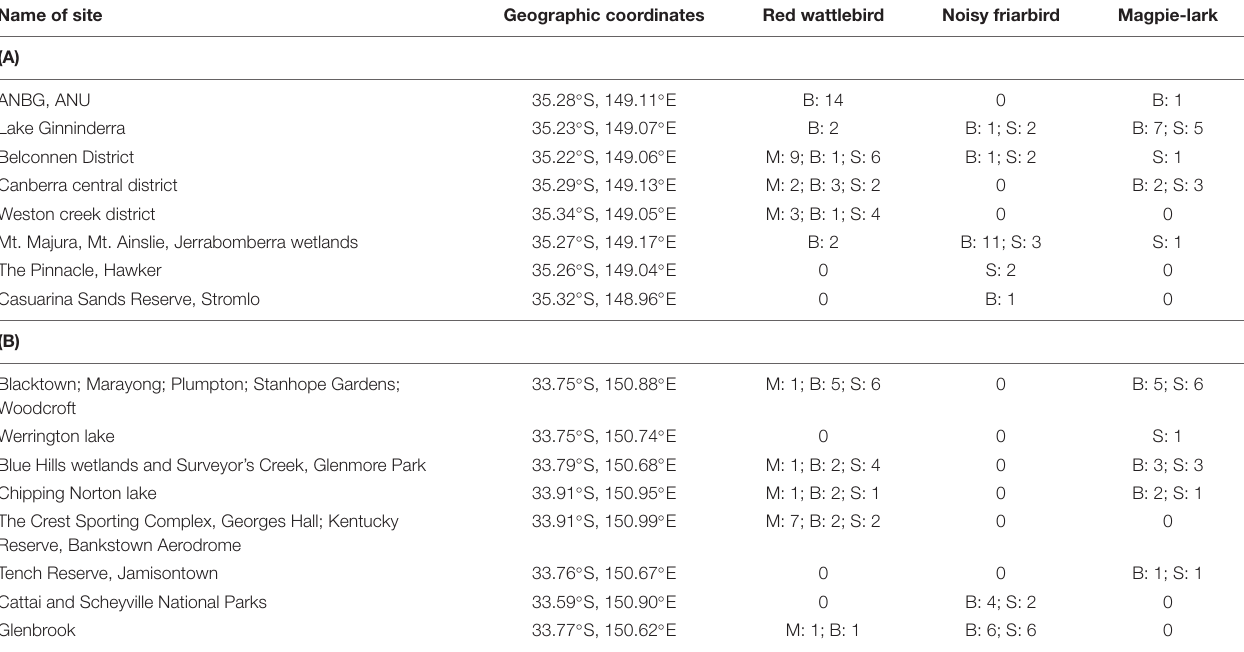
TABLE 1 | Location and number of mobbing and egg ejection experiments performed for each host and egg treatment (“M” = mobbing experiment, “B” = blue egg ejection experiment, “S” = spotted egg ejection experiment) in (A) Canberra, ACT and (B) Western Sydney, NSW. Name of